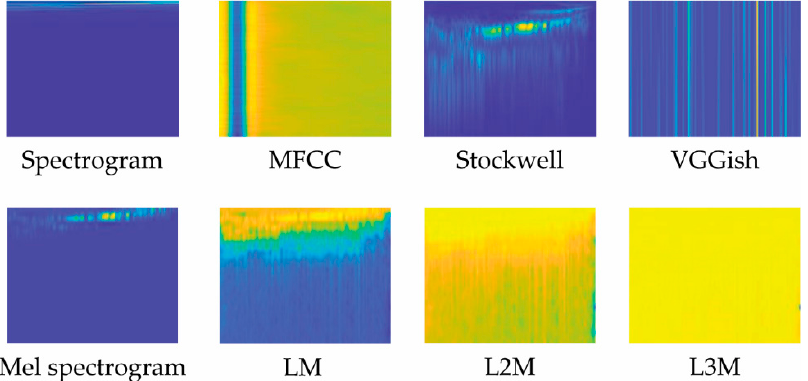
Figure 2. Illustration of the eight audio representations used in this work, each generated from our dataset’s first sample.